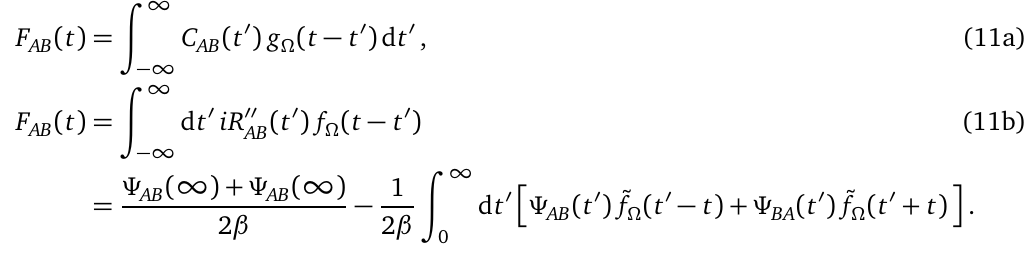
Figure 1: Graphical summary of the t -FDT. The differential operators ˆ regulated fluctuations F ( t ) leading to C ( t ) and R ( t ) . Conversely, by convolution with g Ω ( t ) (and f Ω ( t ) ) one blurs out the details of C ( t ) (and R ( t ) ) going into F ( t )